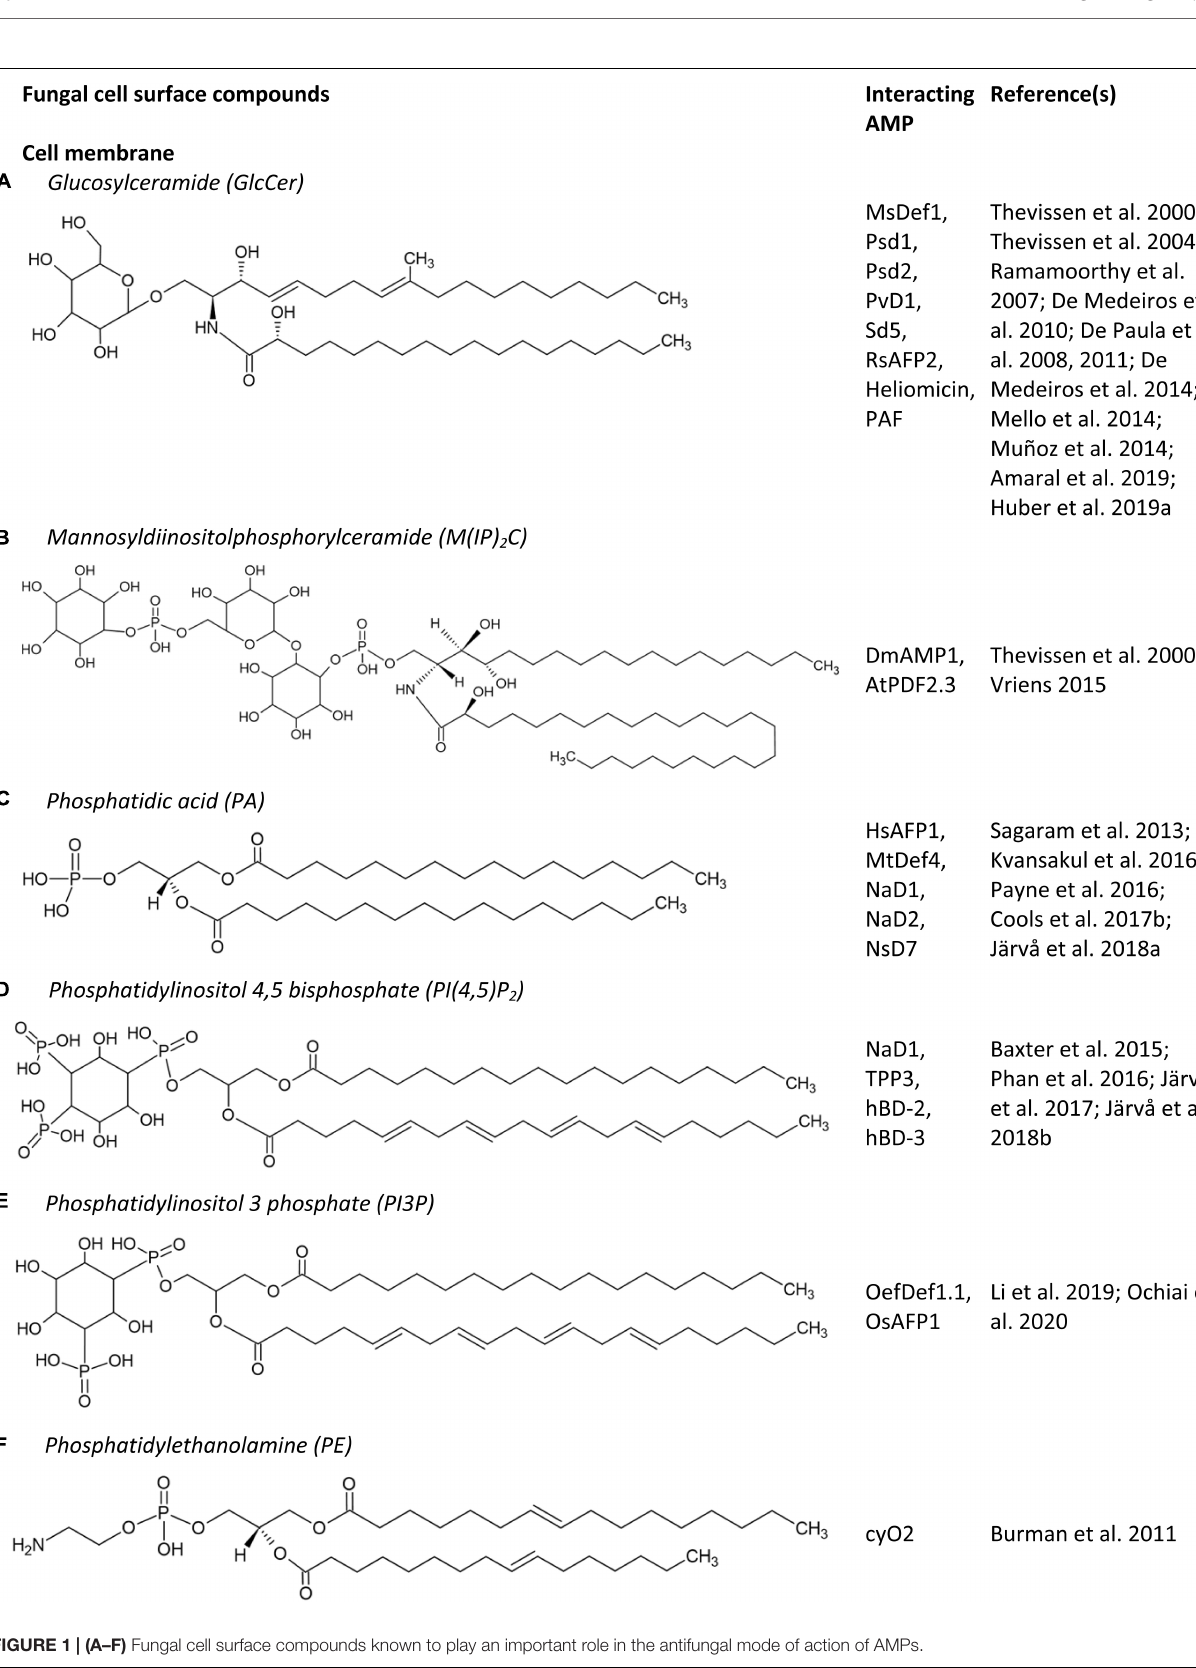
Frontiers in Cell and Developmental Biology |